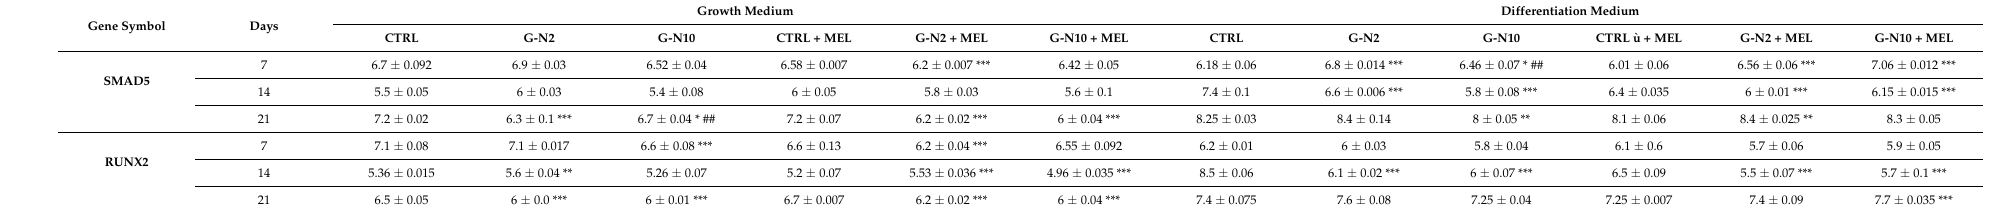
Table 1. Gene expression data.